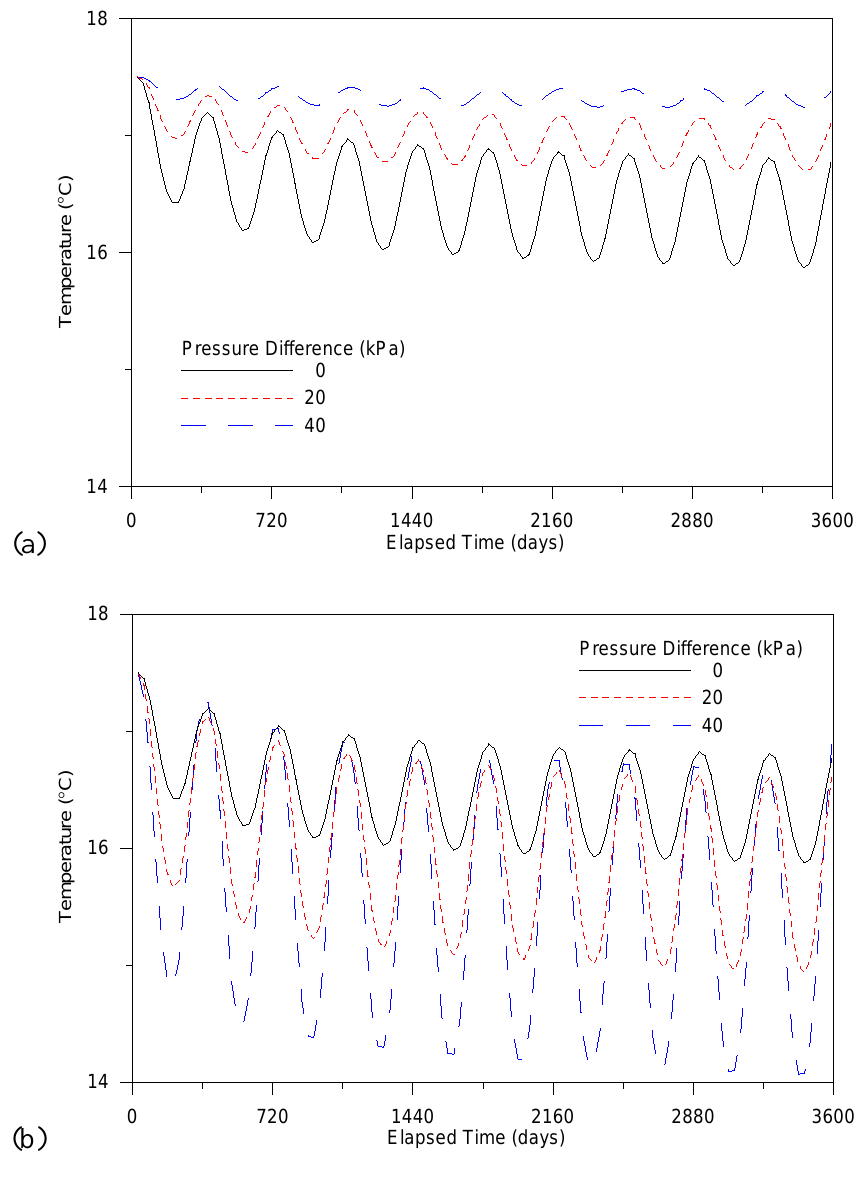
Figure 4. Temperature of produced water obtained from simulations with different groundwater flow condition. (a) groundwater flow from right to left. (b) groundwater flow from left to